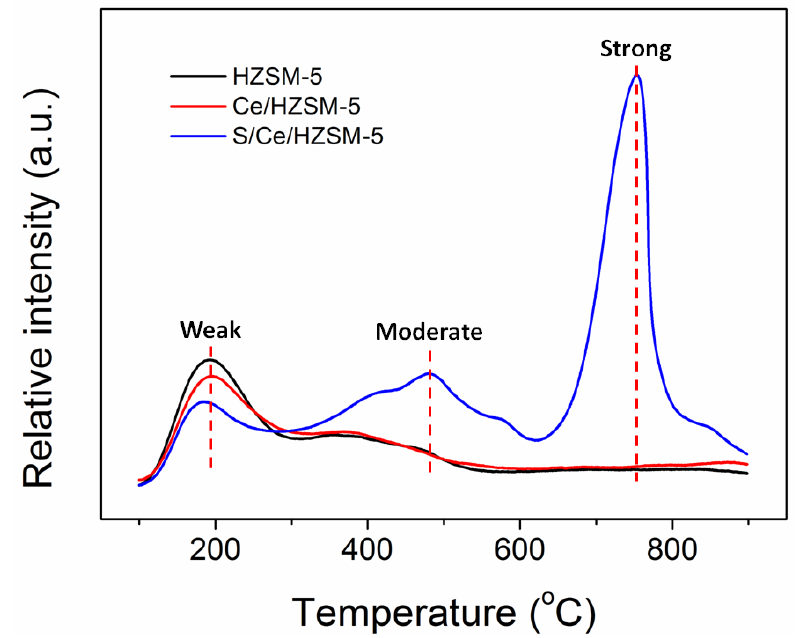
Figure 3. NH 3 -TPD profiles of catalysts. Table 2. NH 3 -TPD acidic sites results for the catalyst.